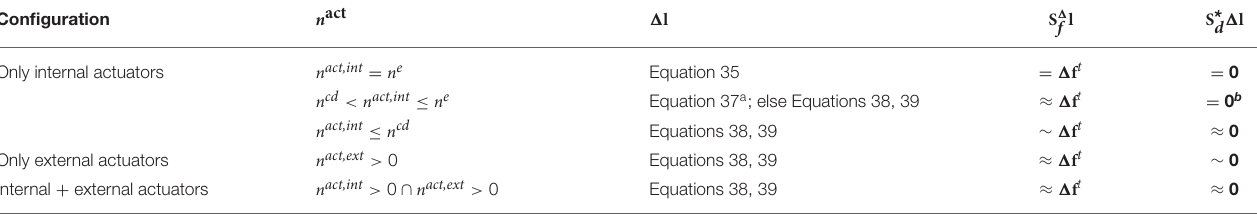
TABLE 3 | Force control through nilpotent eigenstrain